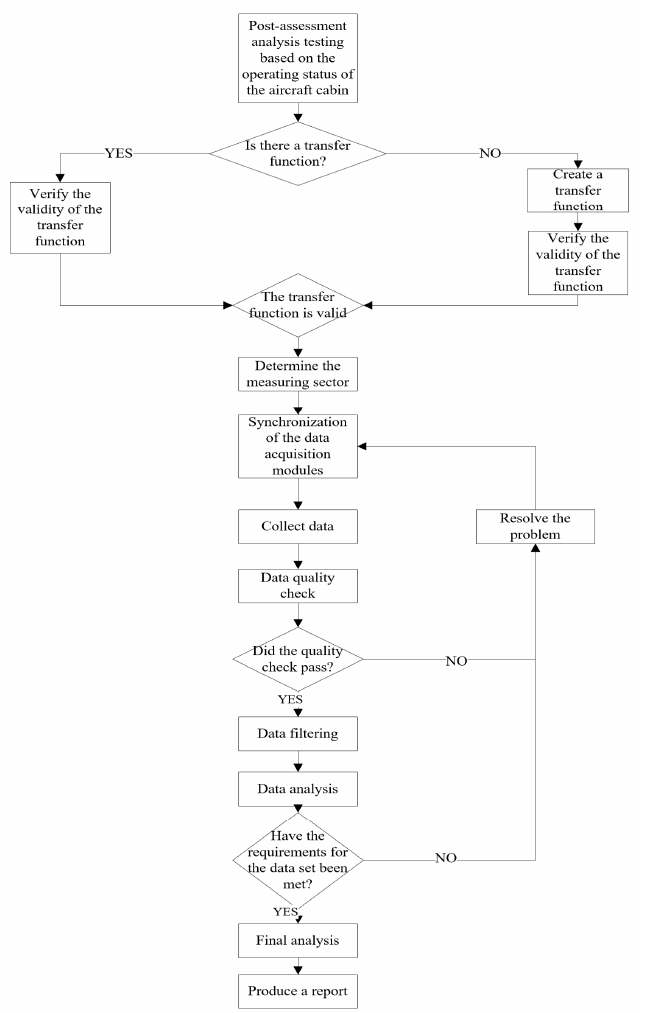
Figure 10. Report